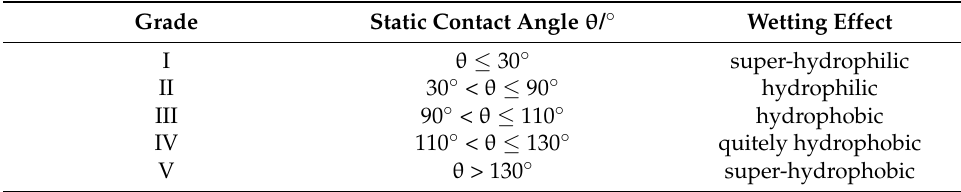
6 of 17 Figure 2. Schematic diagram of water vapor permeability test.